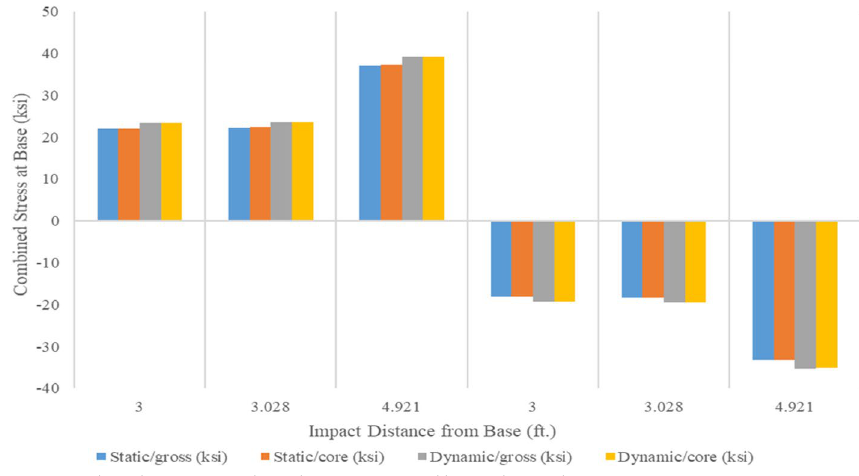
Fig. 9 Combined stresses in column base experienced by single